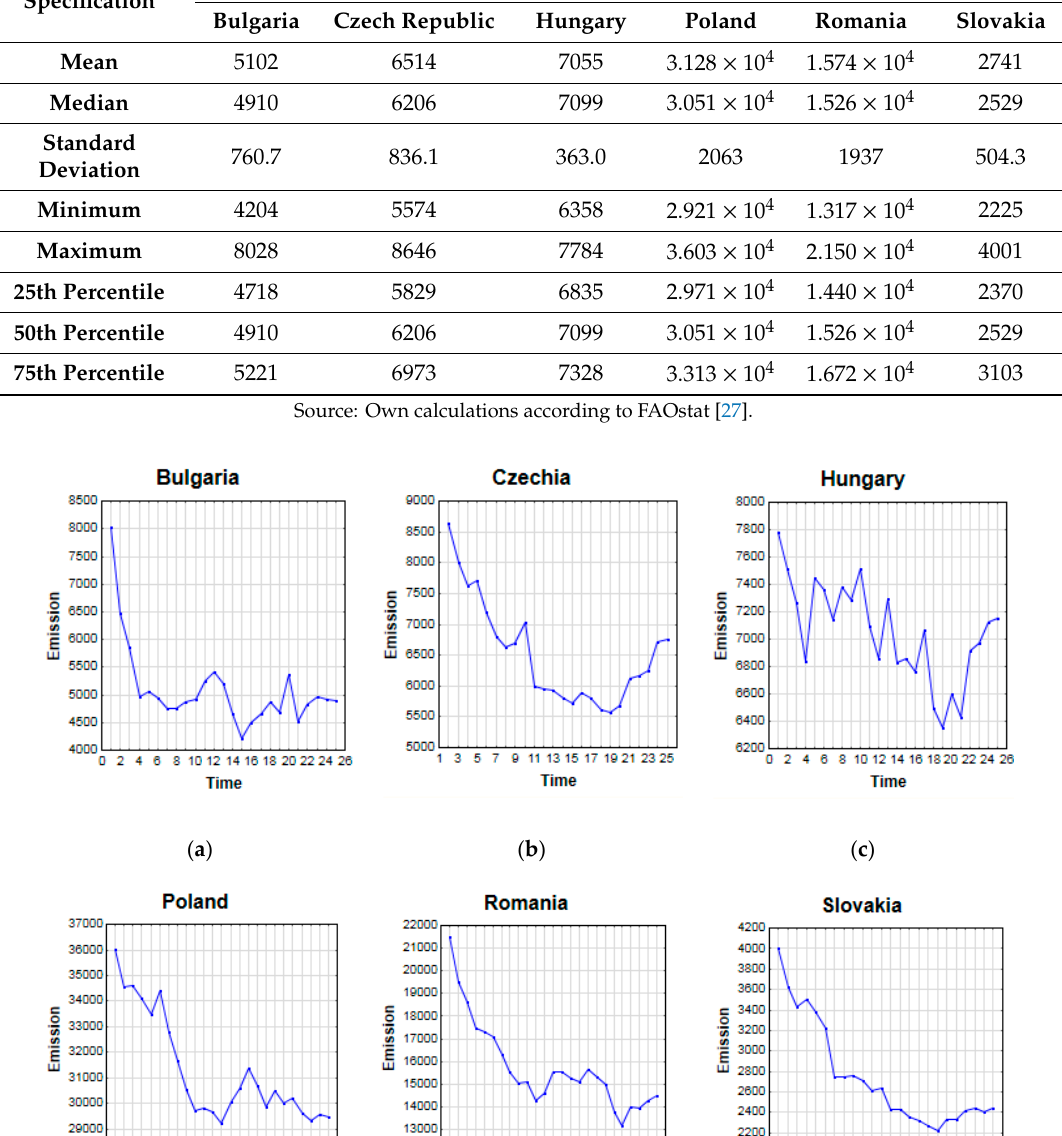
Table 1. CO 2 emission in the countries of Central and Eastern Europe in 1992–2016.